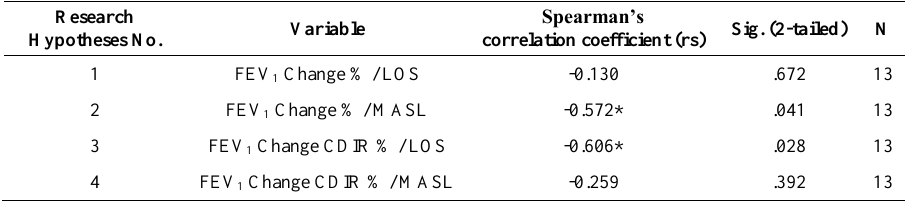
Table 6. Spearman’s rank correlation coefficient for young